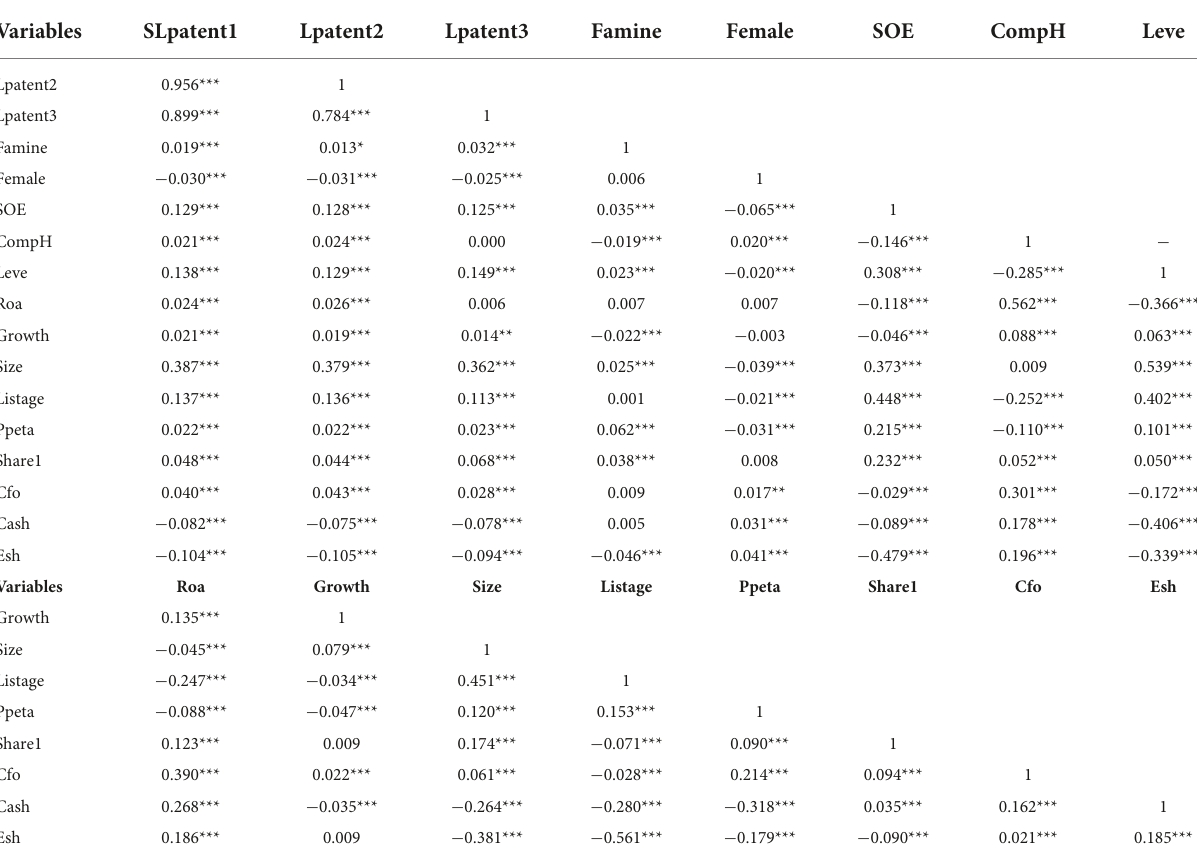
TABLE 3 Correlation coefficient